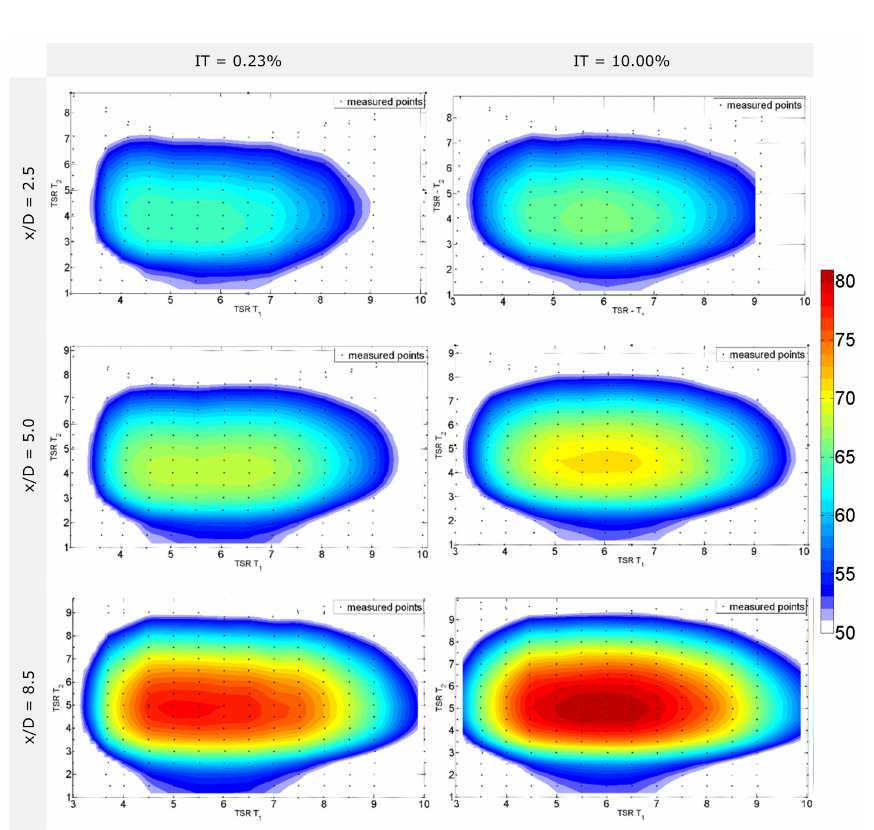
Figure 12. Total efficiency (in %) of two